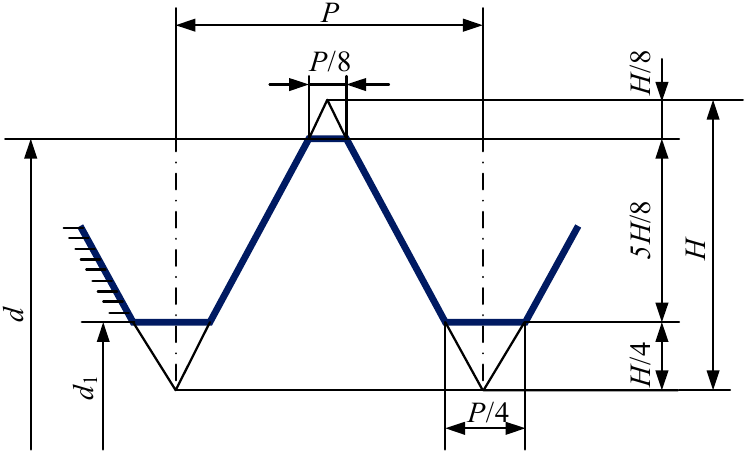
Figure 12. Diagram of the threads of a typical high-strength bolt. Table 9. Parameters for the threads.